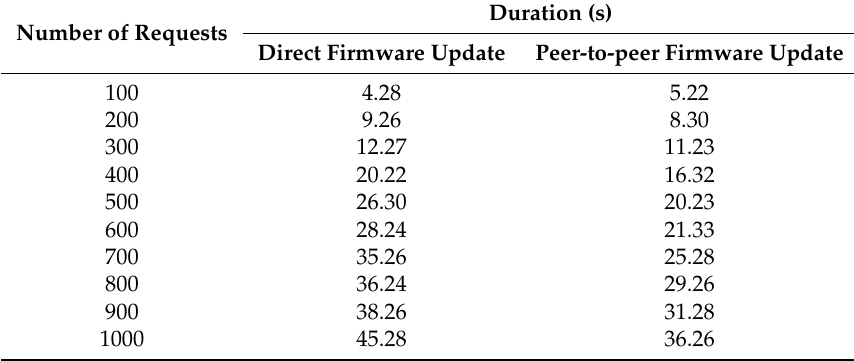
Table 4. Direct firmware update and peer-to-peer firmware update: the results of duration for the Check New Version